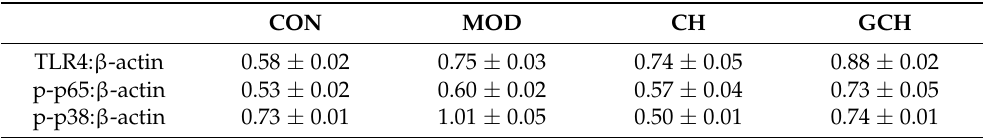
Table 1. The calculated ratios of TLR4: β -actin, p-p65: β -actin, and p-p38: β -actin in the IEC-6 cells treated with casein hydrolysate (CH) and glycated casein hydrolysate (GCH) at 25 µ g/mL for 24 h, followed by a LPS treatment (10 µ g/mL) of 24